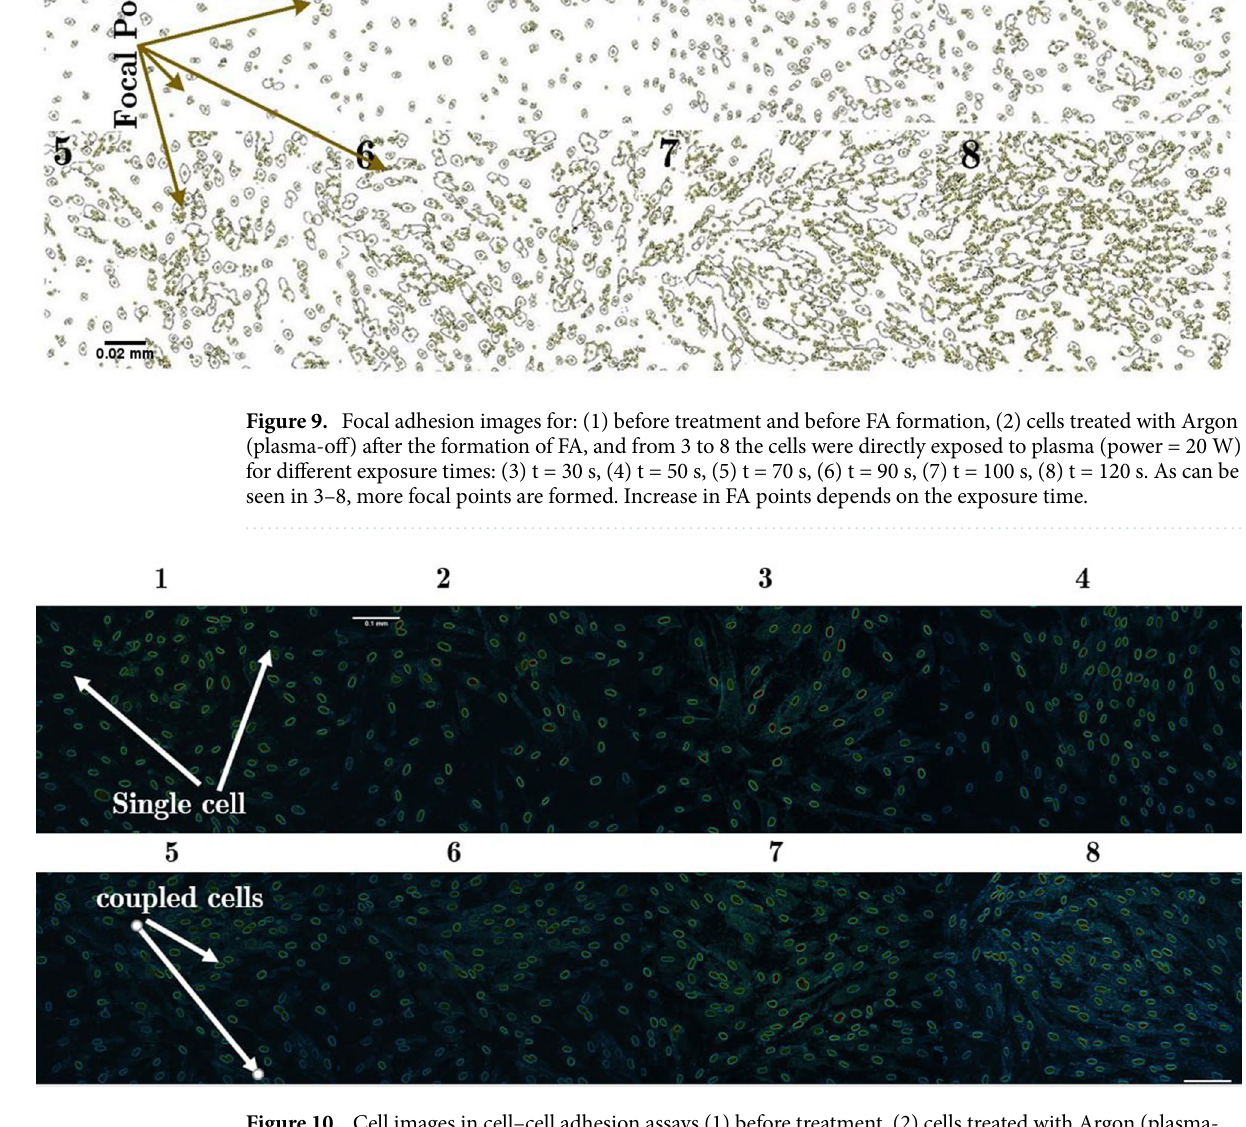
Figure 10. Cell images in cell–cell adhesion assays (1) before treatment, (2) cells treated with Argon (plasma- off). Almost all cells are single. For 3–8, cells were directly exposed to plasma (power = 20 W) with different exposure times: (3) t = 30 s, (4) t = 50 s, (5) t = 70 s, (6) t = 90 s, (7) t = 100 s, (8) t = 120 s. As can be seen in 3–8, more couples are formed after treatment and the number of couples increases depending on the exposure